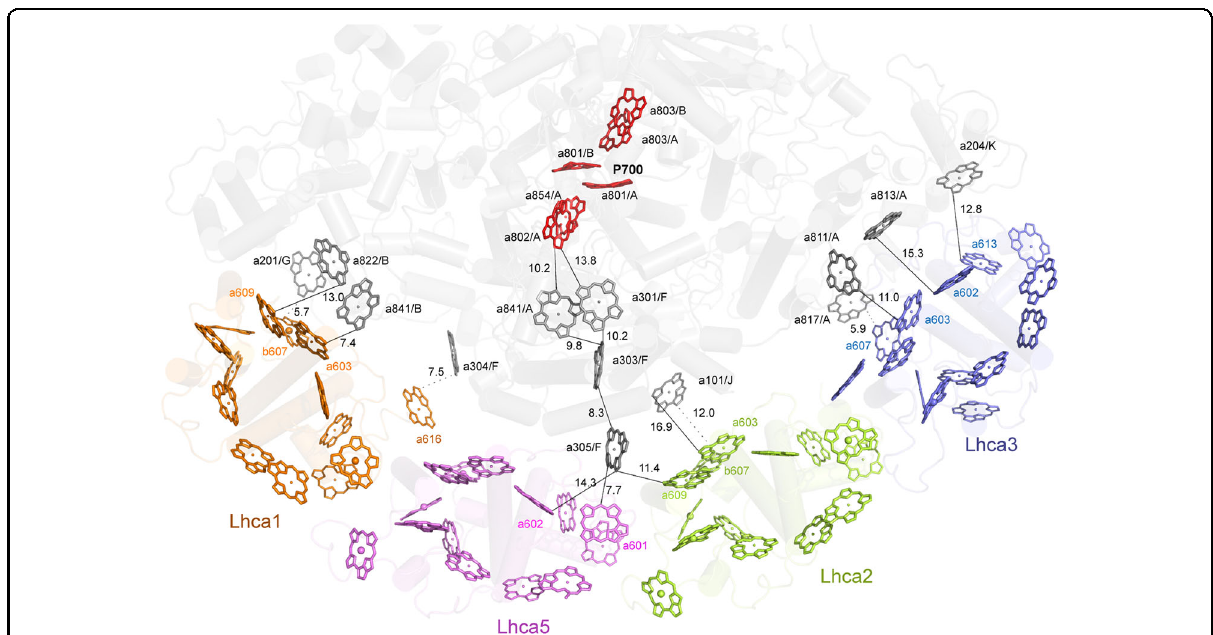
Fig. 7 Plausible energy-transfer pathways from LHCI to the PSI core of P . patens . The color codes for the Chls of each Lhca subunit are the same as Fig. 1. In the PSI core, Chls of the electron transfer chain and reaction center are shown in red, and other Chls are shown in gray. Chls at the stromal layer and lumenal layer are shown in sticks and lines, respectively. Edge-to-edge distances between Chls located at the stromal layer and lumenal layer are indicated by black lines and black dotted lines, respectively. The central magnesium atoms of Chl b are shown in large spheres to distinguish them from Chl a